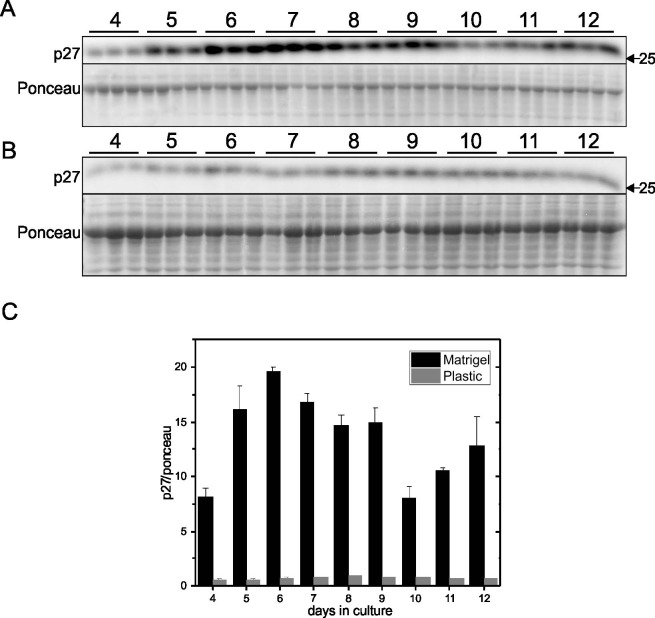
Time course of p27kip1 in EA.hy926 cells grown on Matrigel-coated or plastic culture plates.EA.hy926 endothelial cells were seeded on plastic plates at 9000 cells/cm2 and grown for 12 days. Protein levels of p27kip1 were determined by Western blotting of cell lysates prepared each day from day 4 to day 12. Representative blots are shown in Panel A (Matrigel) and B (Plastic). Densitometry was used to quantify the intensity of the bands in Panel A and B, and data were normalized to a band visualized by Ponceau staining (Panel C). Data are presented as means ± SEM (n = 3).